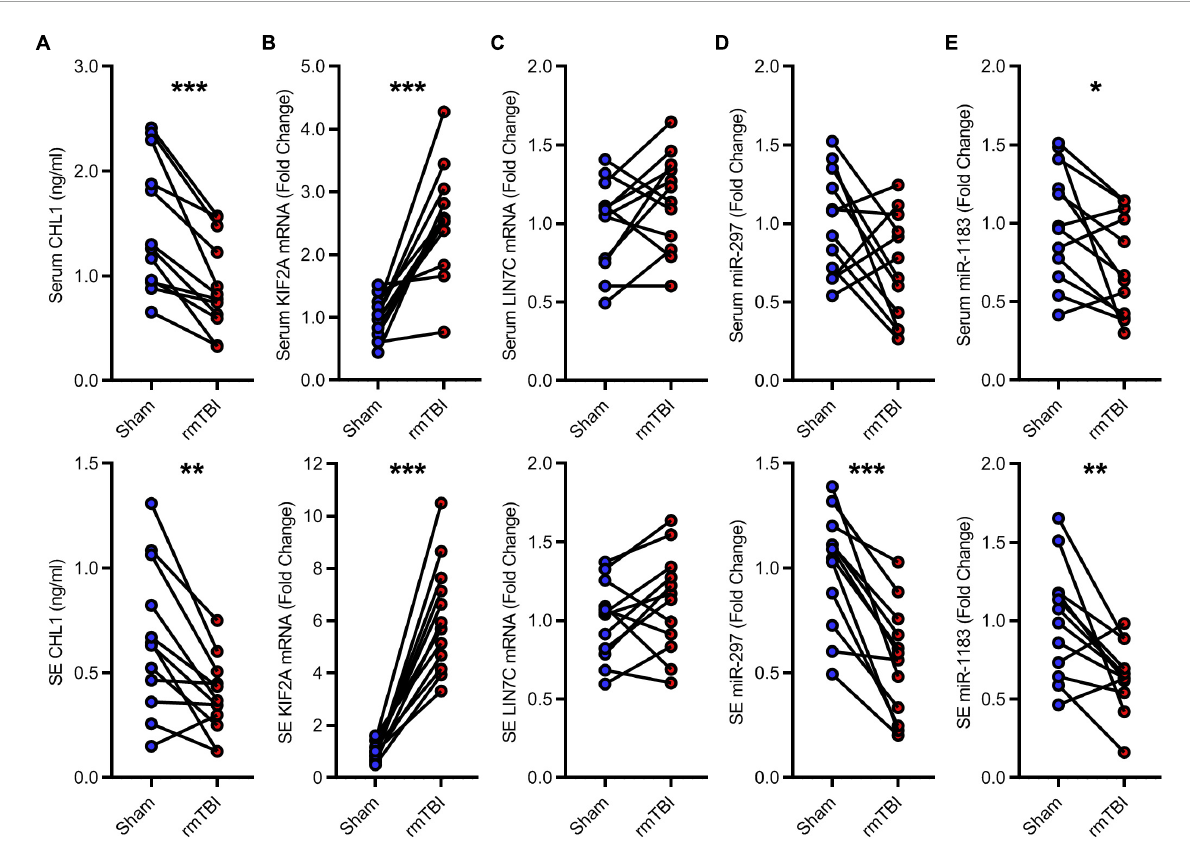
FIGURE5 Low-throughput assays for candidate diagnostic biomarkers for CTE. (A) Quantitative data of ELISA for serum and exosomal CHL1 level in indicated groups. (B–E) Quantitative data of RT-PCR for serum and exosomal KIF2A, LIN7C, hsa-miR-297, hsa-miR-1183. n = 12 per group. Mean ± SD. * P < 0.05, ** P < 0.01, *** P < 0.001. Statistical analyses were performed using two-tailed paired Student’s t -test. SE, serum